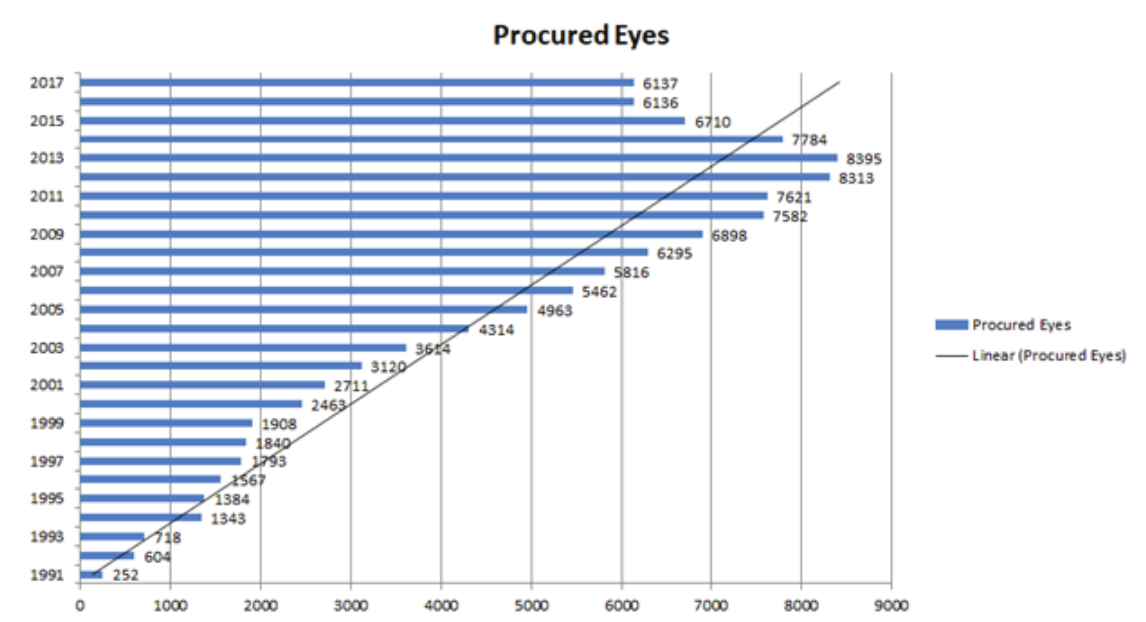
Figure 1. The annual rates of corneal procurement in Iran. Note the increasing rate of corneal procurement between 1991 and